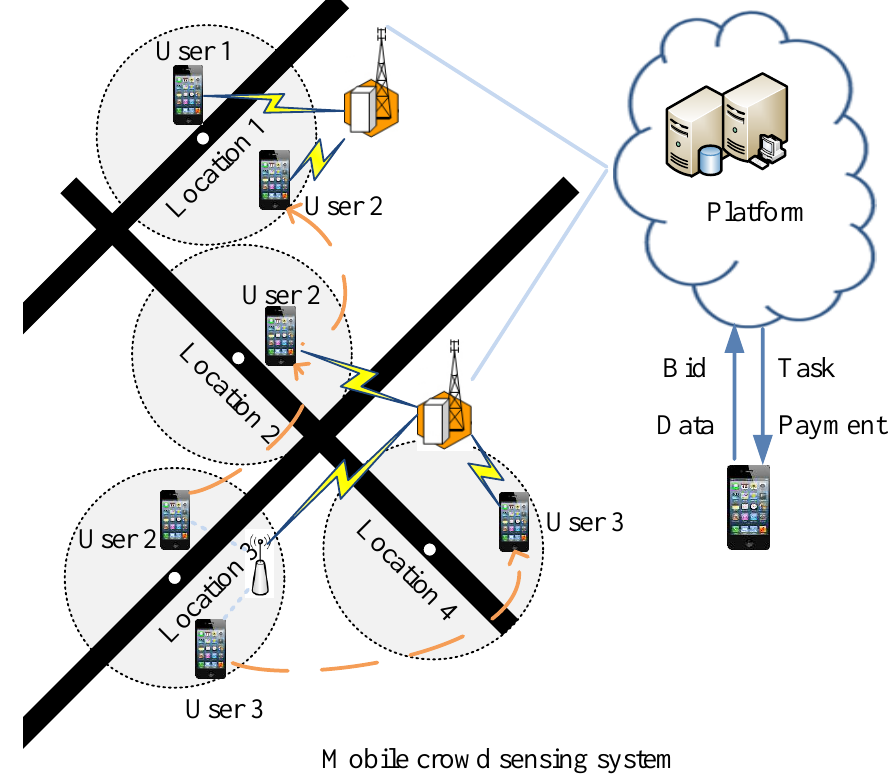
Figure 1. An example of the mobile crowd sensing